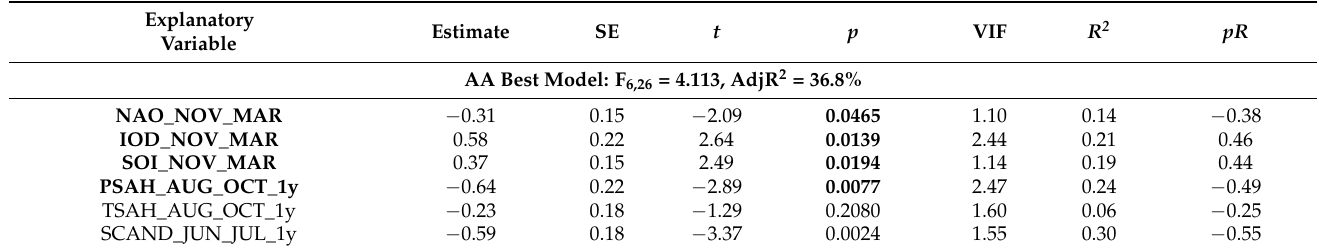
Table A15. Relationships between 15 climate variables and year and Annual Anomaly of the timing of spring migration for the Common Redstart Phoenicurus phoenicurus caught at Bukowo, Poland, in 1982–2021. Symbols as in Tables 1 and A12. p < 0.05 marked in bold face.